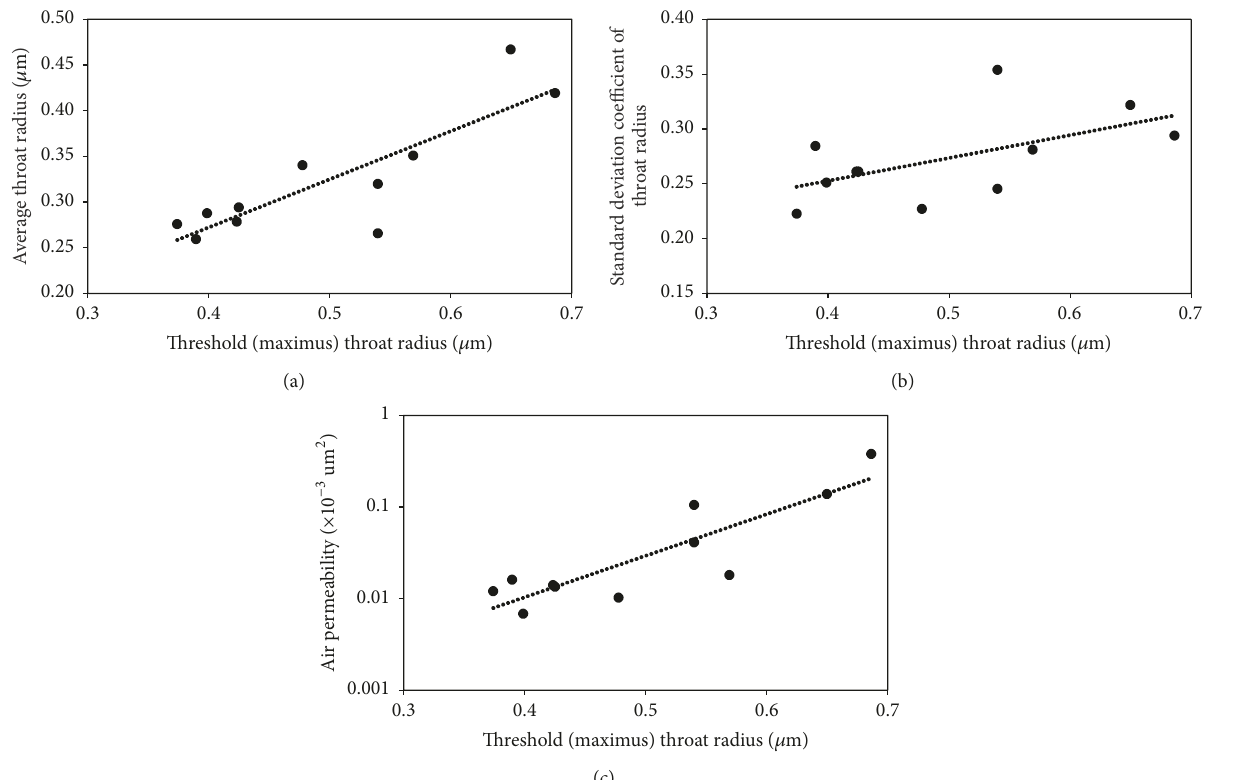
Figure 10: The correlation of threshold (maximum) throat radius to the distribution of the throat radii and permeability of the samples from Upper Triassic Chang 7 Member, Odors Basin.